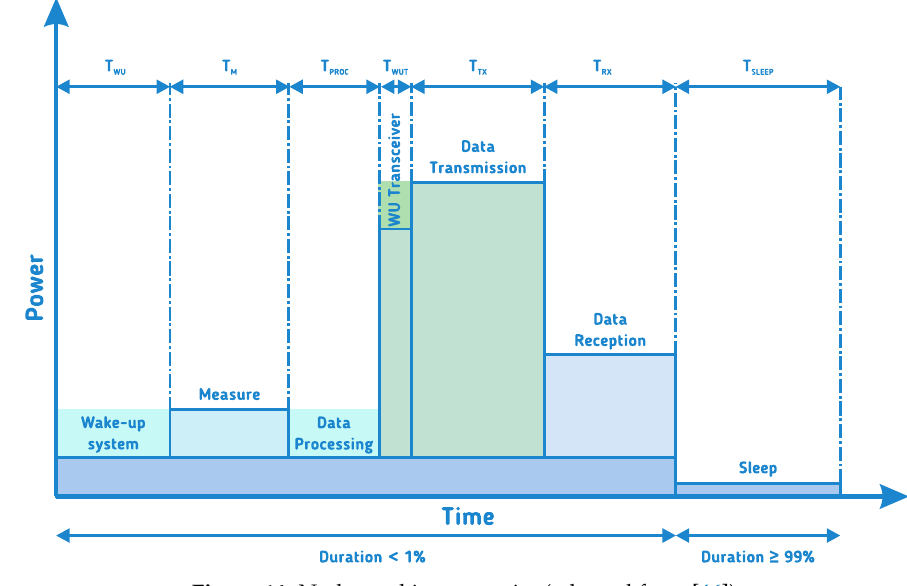
Figure 14. Node working scenario. (adapted from